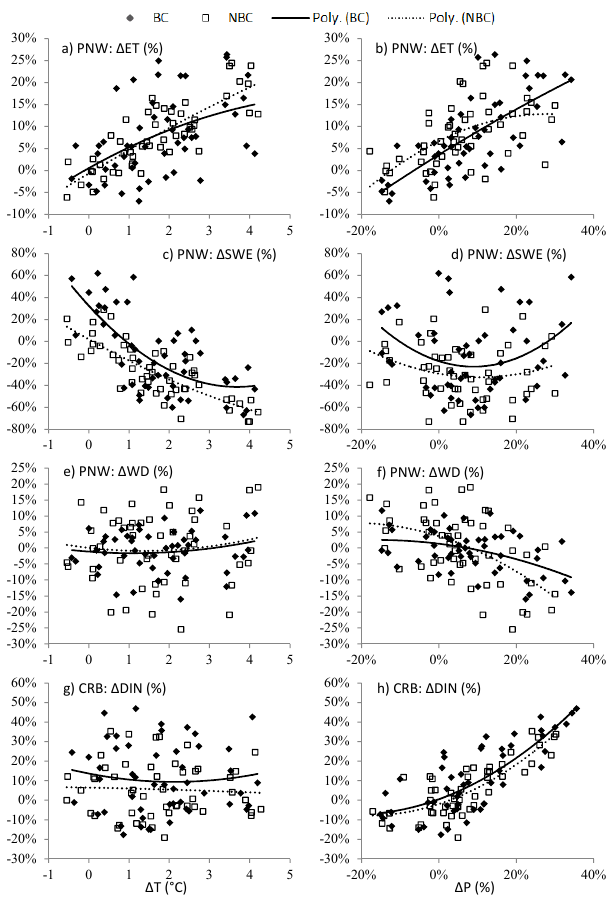
Fig. 8. Land surface response to climate change with bias-corrected (BC) and non-bias-corrected (NBC) data between the 1980s and 2020s and between the 1980s and 2050s. Horizontal axes indicate the anomaly of T (left column, ◦ C) or the anomaly of P (right column, %). Vertical axes indicate anomalies of evapotranspiration (ET), snowpack water equivalent (SWE), irrigation water demand (WD), export of dissolved inorganic nitrogen (DIN), and net pri- mary productivity (NPP) in responding to BC and NBC climate data. Diamonds represent anomalies according to BC climate and rectangles represent estimated anomalies driven by NBC climate in each future year comparing with the base period of the 1980s. The black lines represent second-order polynomial regression curves for responses and BC climate, and dashed lines represent second-order polynomial repression curves for responses and NBC climate. PNW (Pacific Northwest) represents the domain for ET, SWE, and WD estimations from VIC or VIC-CropSyst models; CRB represents the simulation domain of NEWS model; and HJ-Andrews repre- sents the simulation domain of RHESSys on ET and NPP (Fig. 1).